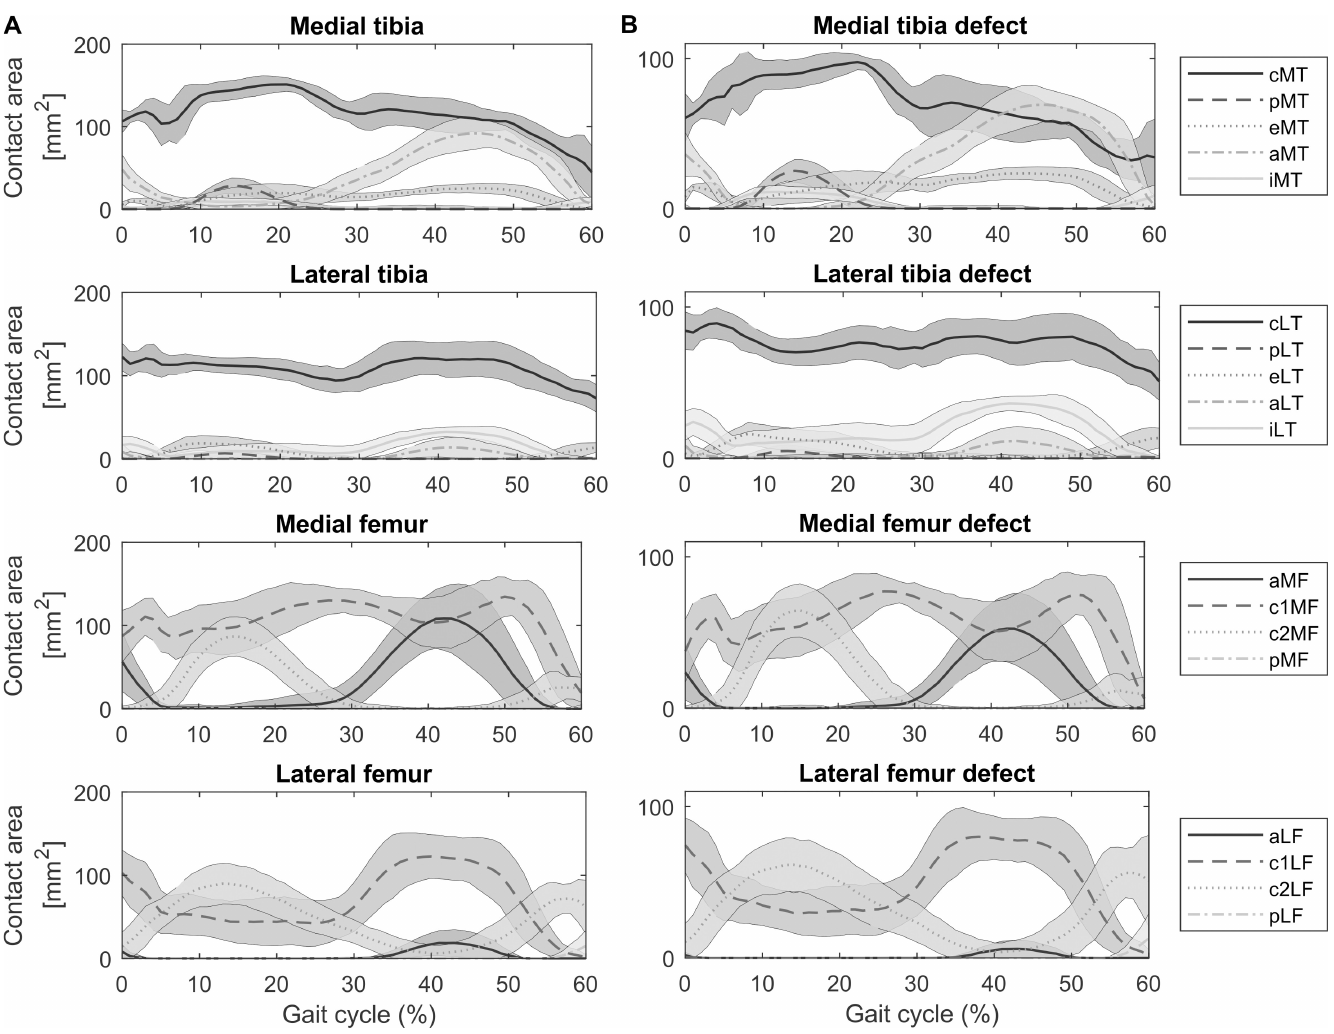
Fig 2. Cartilage contact area for different cartilage regions throughout the stance phase of gait. (A) Cartilage contact areas in the medial and lateral compartments of the tibia and femur for the different regions of interest throughout the stance phase of gait as defined in Fig 1. (abbreviations: MT–medial tibia, LT–lateral tibia, MF– medial femur, LF–lateral femur, c–central, p–posterior, e–external, a–anterior, i–internal, c1 –anterior-central, c2 –posterior-central). (B) Coverage of 100mm 2 cartilage defects throughout the stance phase of gait.